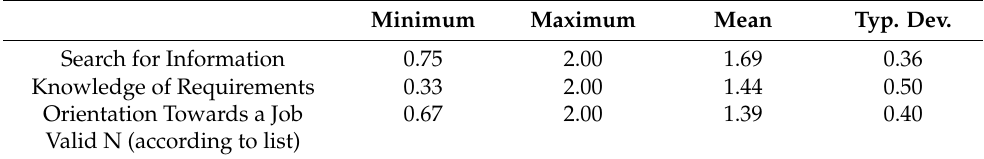
Table 2. Descriptive statistics for the EMI